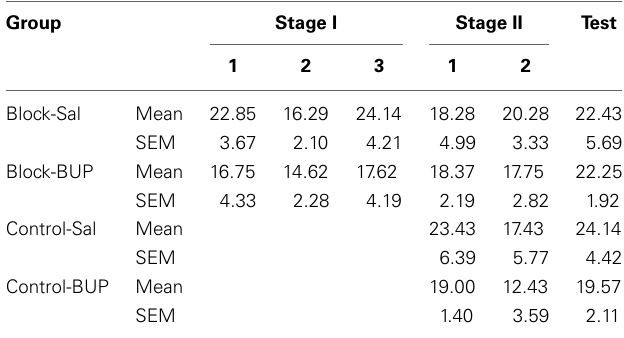
Table 1 | Mean and standard error of the mean (SEM) PreCS lever pressing across the first trial of Stage I, Stage II, and